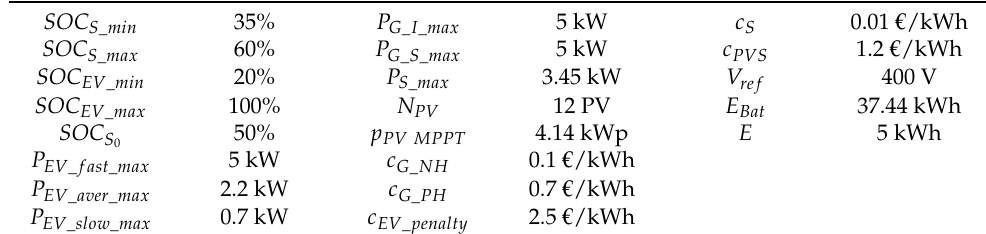
Table 3. Real-time experiment parameter values.